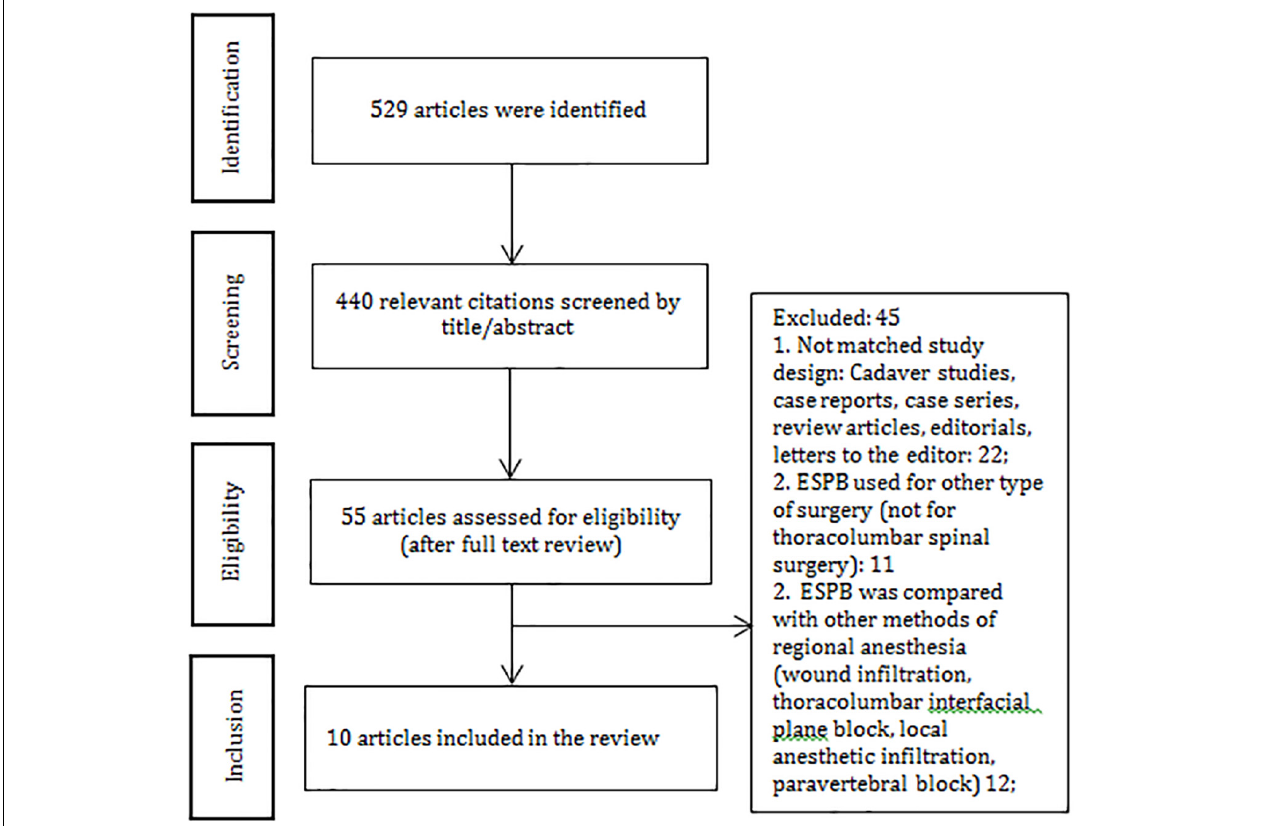
FIGURE 1 | PRISMA